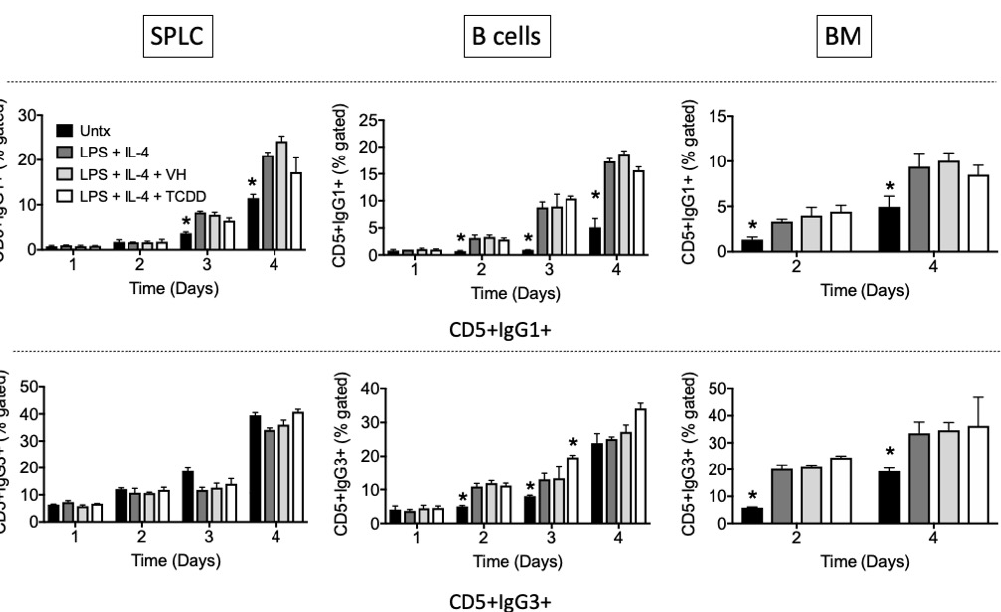
Figure 10. TCDD did not inhibit the percentage of CD5+IgG1+ or CD5+IgG3+ cells. SPLC, B cells or BM cells were treated with VH (0.01% DMSO) or TCDD (30 nM) for 30 min then were stimulated with LPS + IL-4 (5 µg/mL + 10 ng/mL). Cells were incubated for 1, 2, 3 or 4 days then stained for CD19, B220, CD5 IgG1 and IgG3 (top, IgG1; bottom, IgG3; CD5 shown only). Cells were gated on live single lymphocytes. Bars represent mean ± SD from triplicate samples. Untx, untreated; VH, vehicle. * p < 0.05 as compared to respective LPS + IL-4 + VH control within day. Experiments were repeated at least twice.